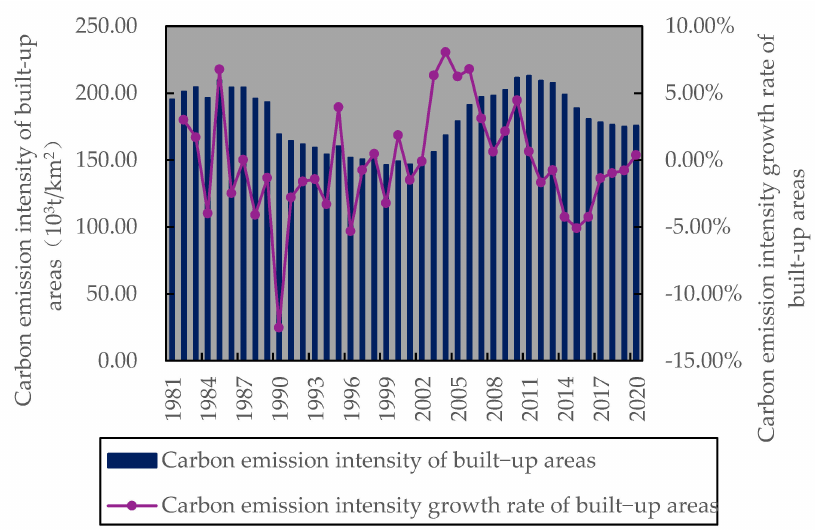
Figure 3. Carbon emission intensity and growth rate of built-up areas from 1981 to